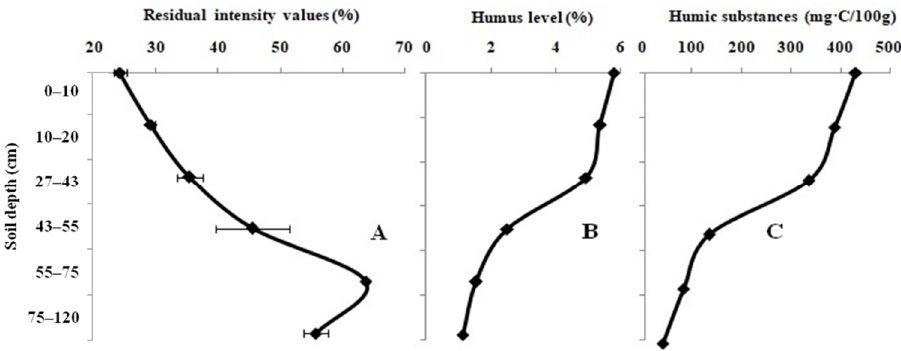
Figure 1. Variation in the residual light intensity of the Red + Luc enzyme system ( A ); humic ( B ) and labile humic substances ( C ) in the full profile of the agricultural-grassland samples.